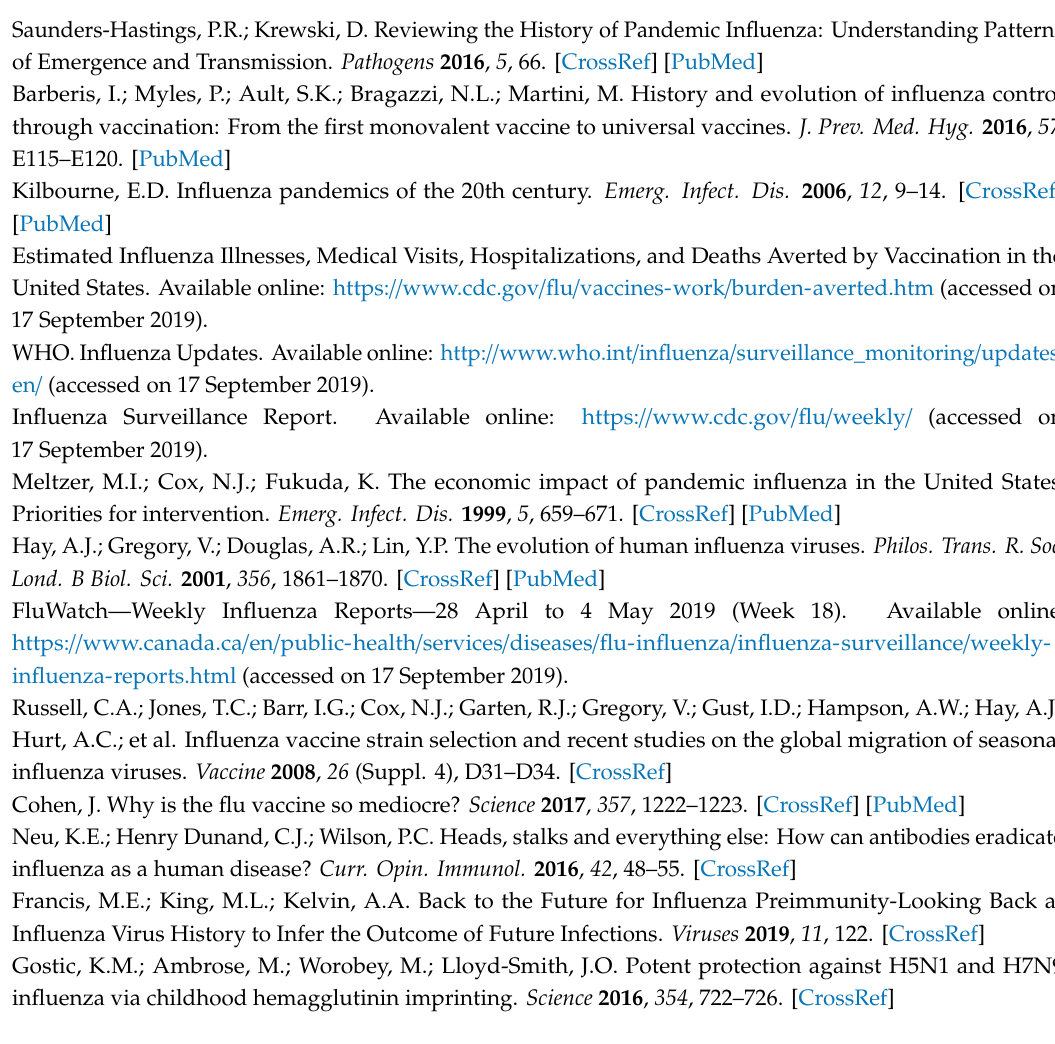
Figure S1: Weight loss and temperature change following infection with A / USSR / 90 / 1977 to establish a preimmune background. Figure S2: Histogram visualization of HAI titer regulation over the experimental time course found preimmune ferrets had greater antibody responses compared to naïve-vaccinated ferrets. Figure S3: Minimal weight loss and temperature change were observed following vaccination with Sanofi FLUZONE ®